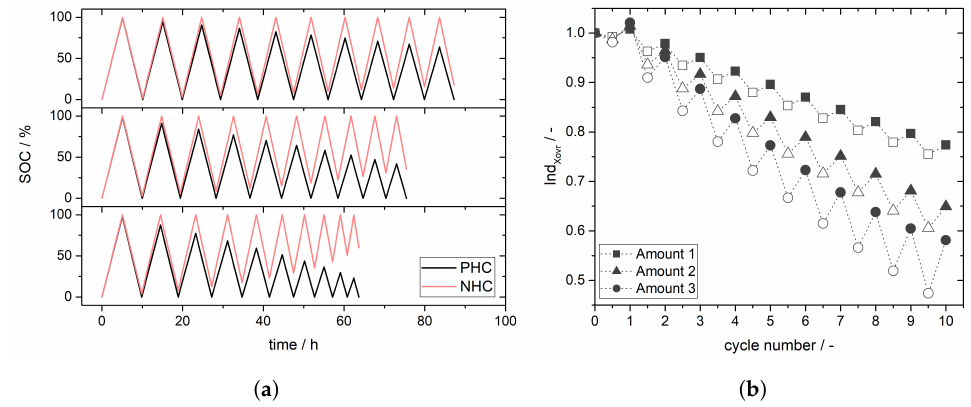
Figure 5. ( a ) Simulated SOC curves for case I and different crossover quantities. The amount of vanadium ions crossing increases from top to bottom (Amount 1 < Amount 2 < Amount 3). ( b ) Crossover index Ind Xovr calculated from the data in ( a ) According to cycle numbers full numbers display a discharge half-cycle (filled icons) and half numbers (x,5) display a charge half-cycle (empty